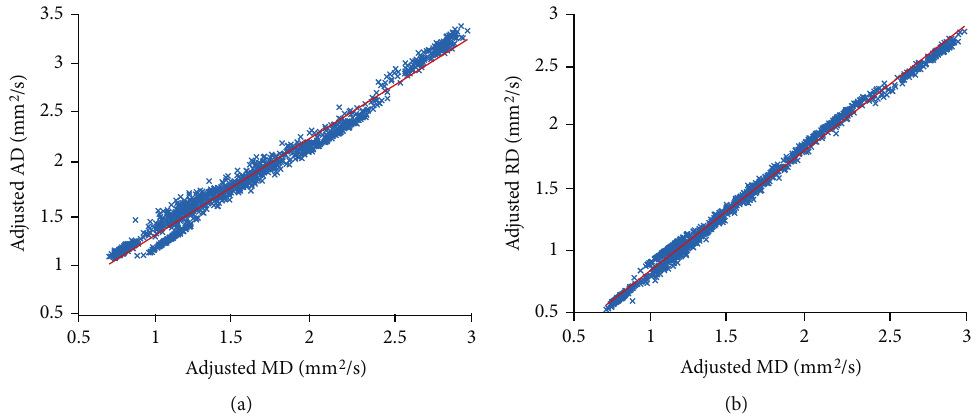
Figure 4: Scatter plots showing the correlation between MD and AD (a) ( p value < 0.001, r = 0 : 990 ) as well as MD and RD (b) ( p value < 0.001, r = 0 : 998